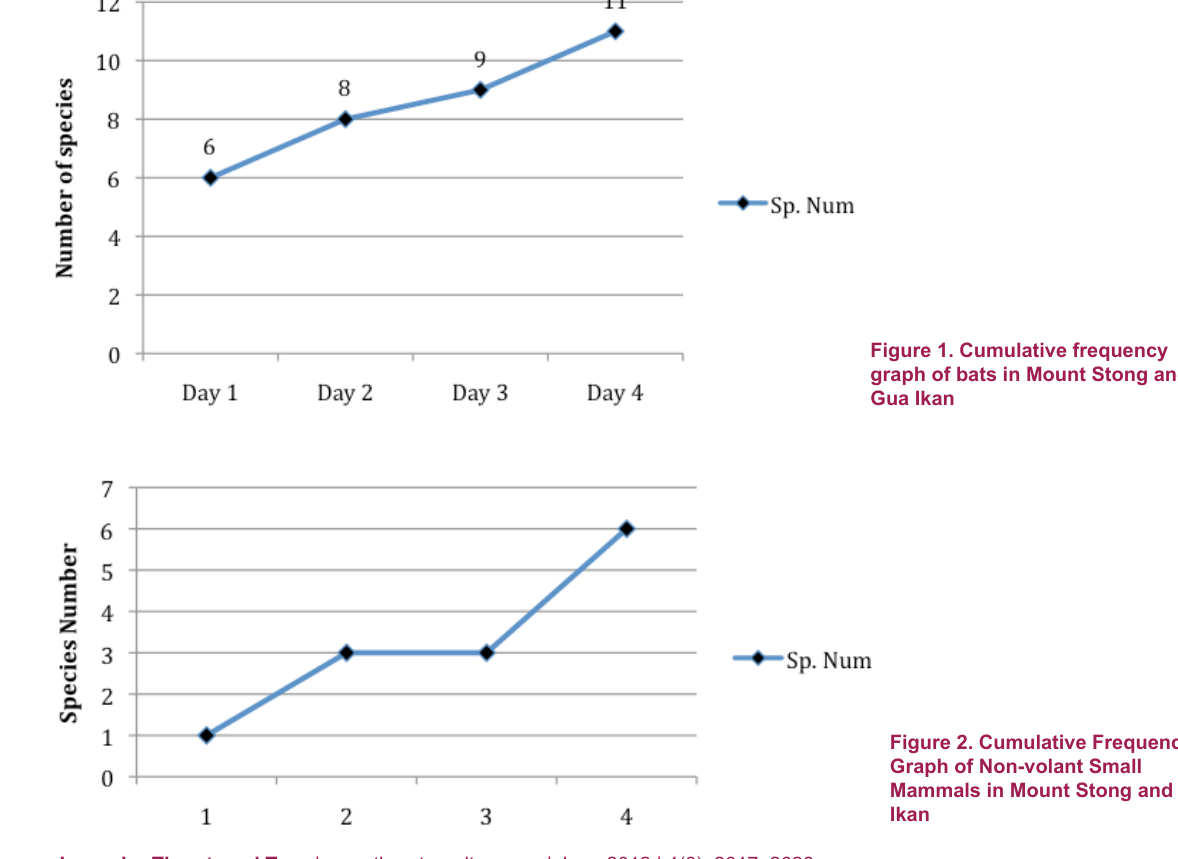
Figure 1. Cumulative frequency graph of bats in Mount Stong and